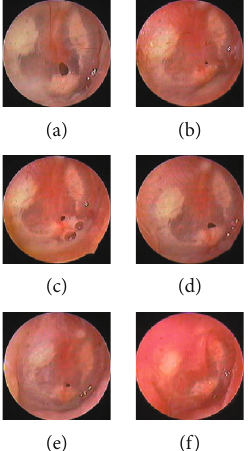
Figure 5: (Patient 12): a 48-year-old woman with COM and a right small perforation. Pretreatment perforation (a) and the perforation at 3 (b), 4 (c), 5 (d), 6 (e), and 8 (f) weeks after starting